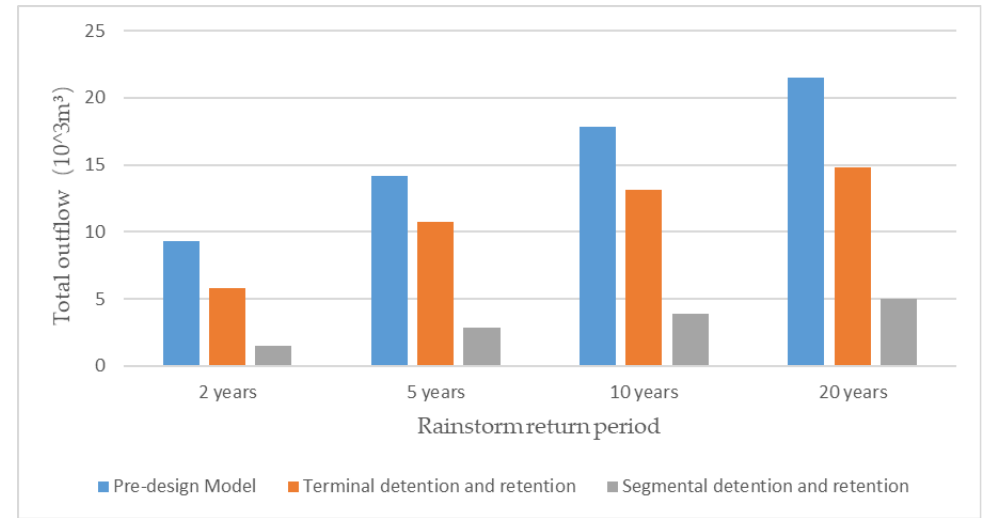
Figure 9. Comparison of Total Outflows between the Pre-design Model, Scheme S and Scheme T under rainfall events in different return periods.